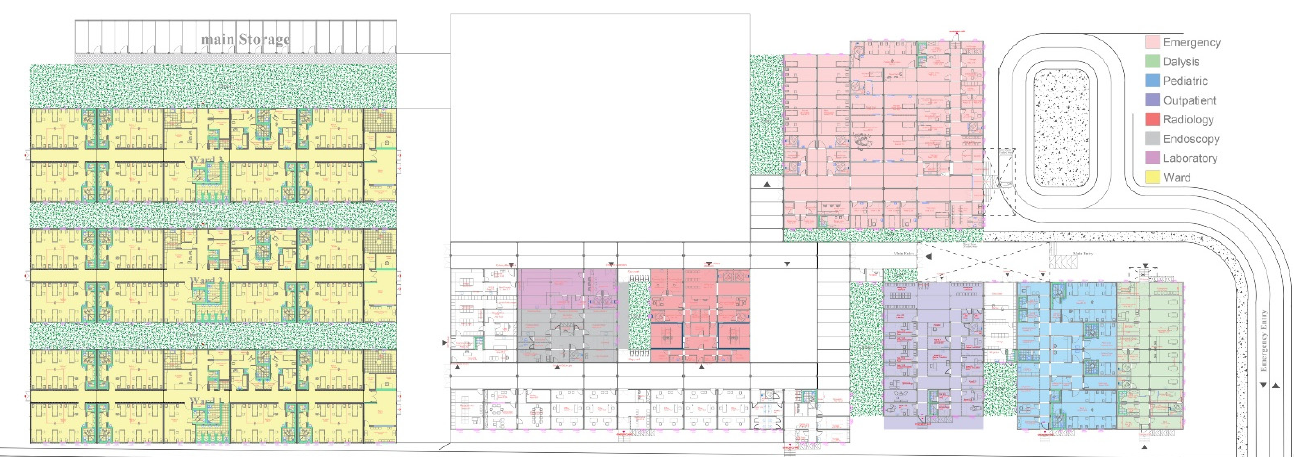
Figure A1. Site plan of the relocatable hospital in Mosul city, Case study.